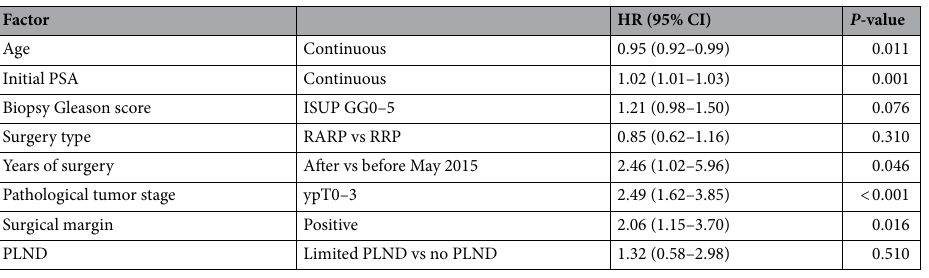
Table 3. Multivariate Cox regression analysis for biochemical recurrence-free survival in the overall cohort. HR hazard ratio, CI confidence interval, PSA prostate-specific antigen, ISUP GG the International Society of Urological Pathology grade group, RARP robot-assisted radical prostatectomy, RRP retropubic radical prostatectomy, PLND pelvic lymph node